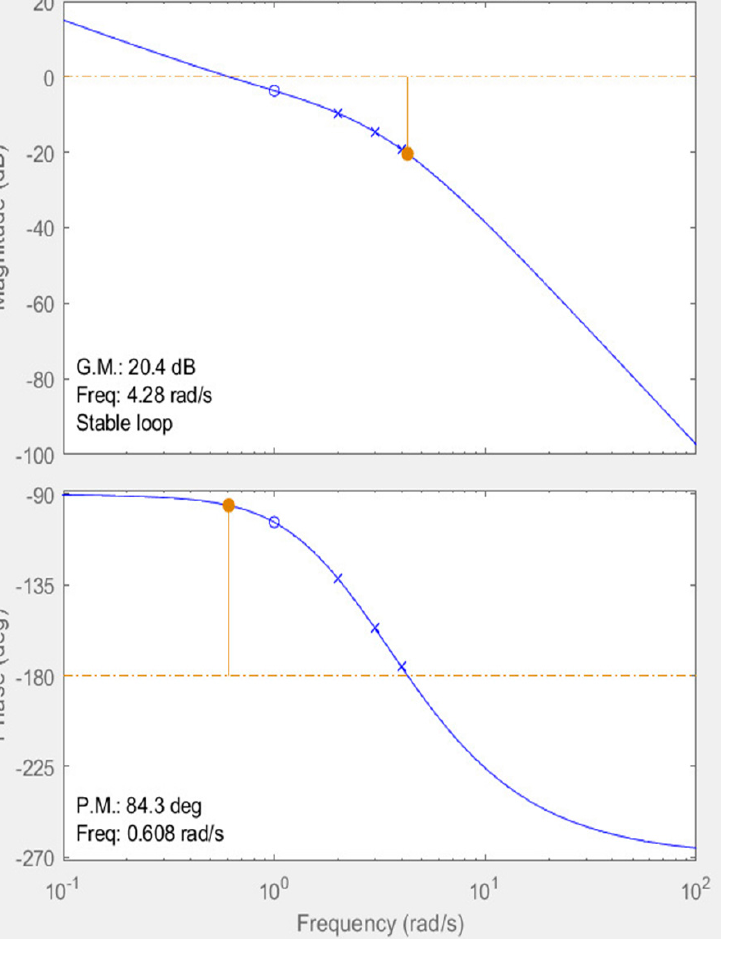
Figure A1. Bode plot to observe stability of the proposed converter system.